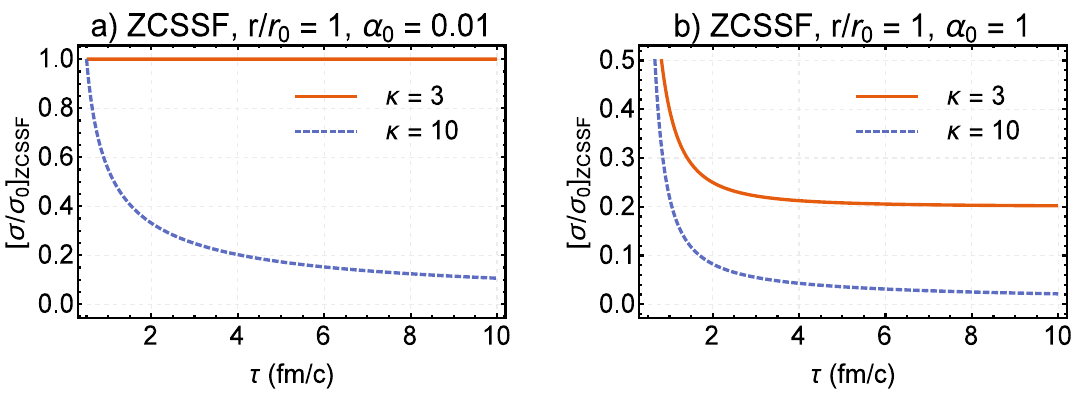
Figure 6 . (color online). The r dependence of λ/λ 0 for the ZCSSF solution (panel a) and the CMHD solution (panel b) is plotted at τ = 4 τ 0 and for α 0 = 0 . 01 (solid orange curves) and α 0 = 1 (dashed blue curves). For the CMHD solution q is chosen to be q = 1 / 4 . 3 fm − 1 . Whereas [ λ/λ 0 ] ZCSSF increases with increasing r , and it is slightly suppressed once larger values of α 0 are chosen, the r dependence of [ λ/λ 0 ] CMHD share the same properties with its τ dependence, i.e. for α 0 being small enough, a relatively large maximum appears that then slowly decays. For larger values of α 0 , [ λ/λ 0 ] CMHD remains small.